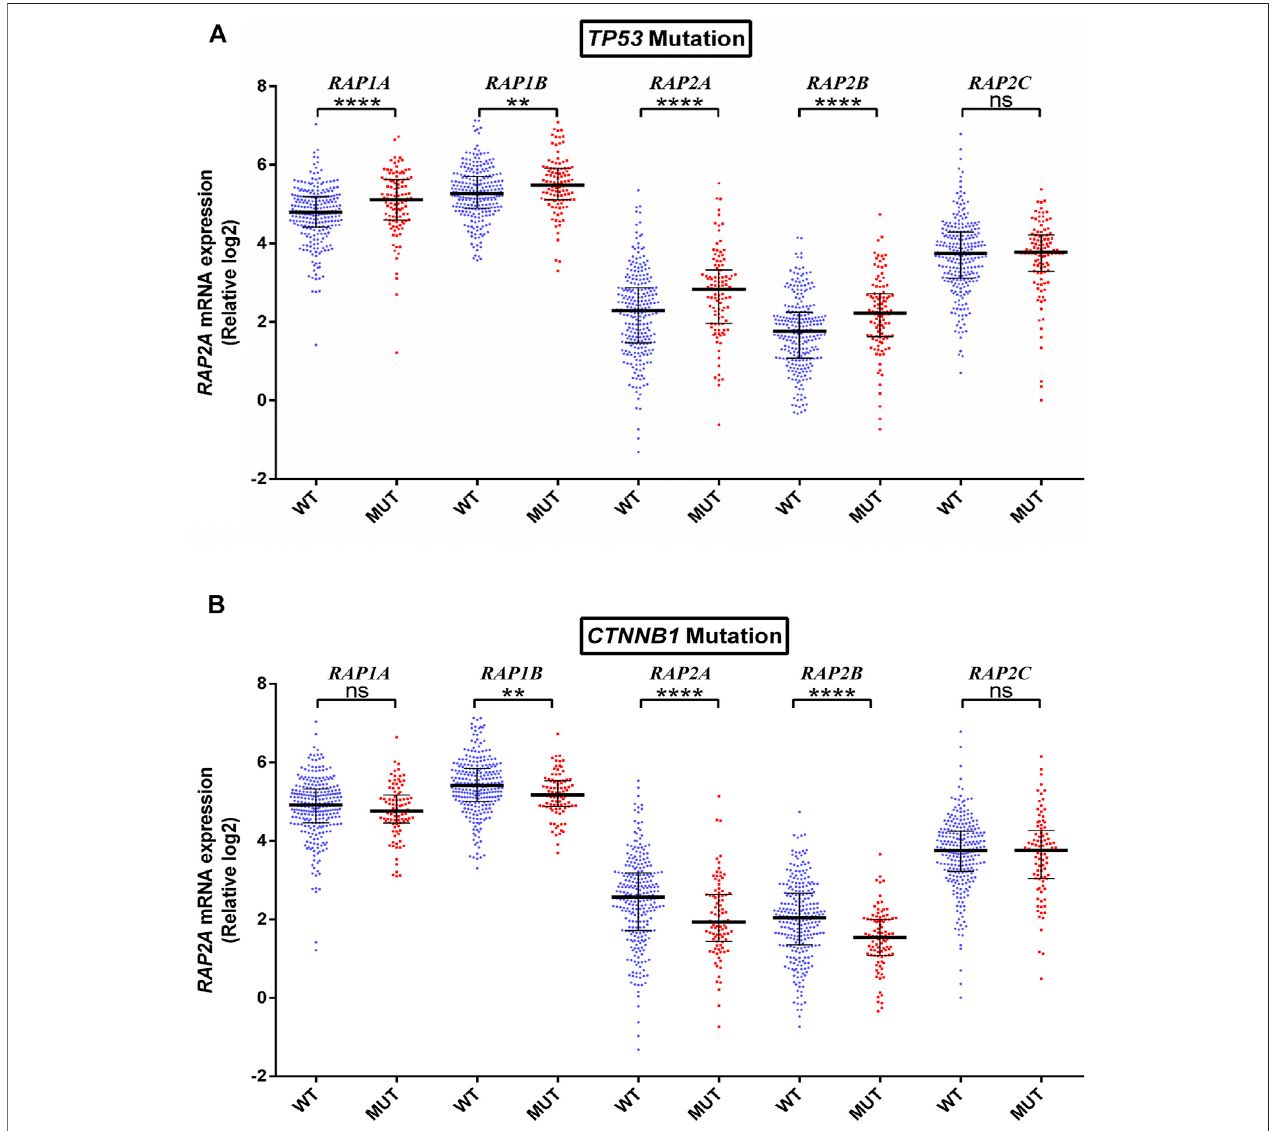
FIGURE5| AssociationofRAPexpressioninTCGA-KIRCdatasetwith (A) TP53mutation,and (B )CTNNB1mutation.**** p < 0.0001;*** p < 0.001;** p < 0.01;* p < 0.05; ns, p > 0.05.